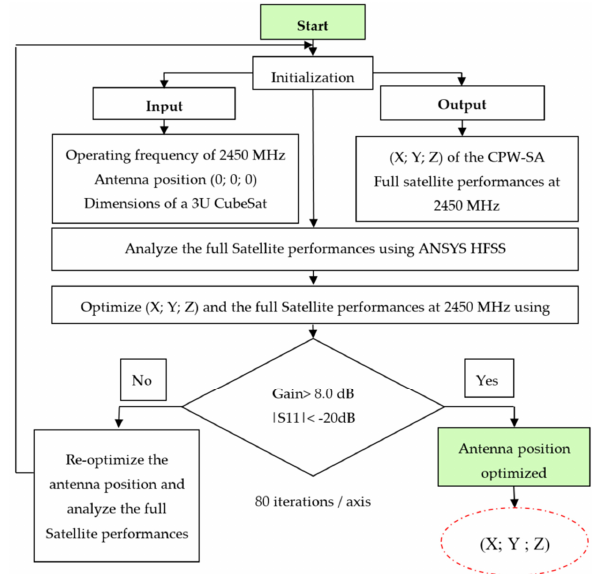
Figure A2. Flow chart of the QNM program used to optimize the antenna position. In the present study, the proposed QNM scenario gives good solution of antenna placement at 2450 MHz when for x = − 7.5 cm, y = 5 cm, and Ha = 16.8 mm. The antenna satisfied all proposed criteria, is high-gain, and occupies physical size suitable for all CubeSat configurations including 3U